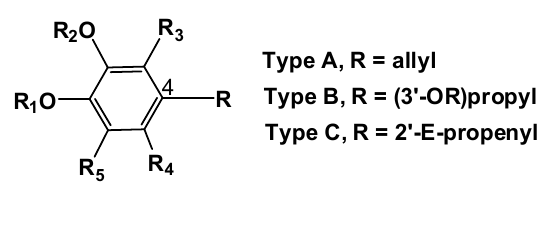
Figure 1. Analogues of eugenol grouped according to the